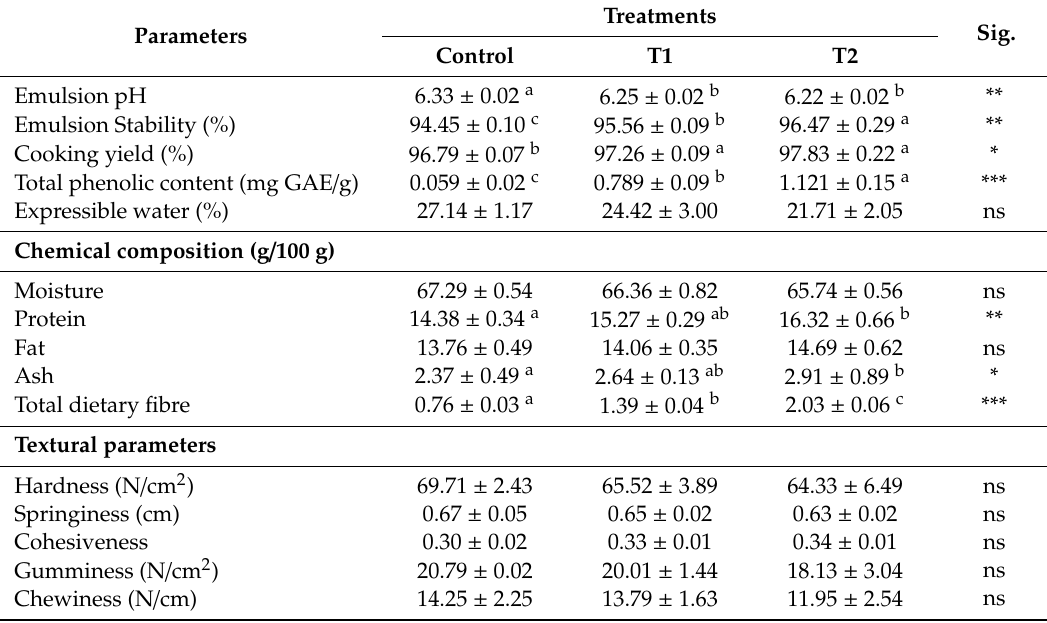
Table 3. E ff ect of Moringa flower on physico-chemical parameters of chicken nuggets (mean values ± error standard of six